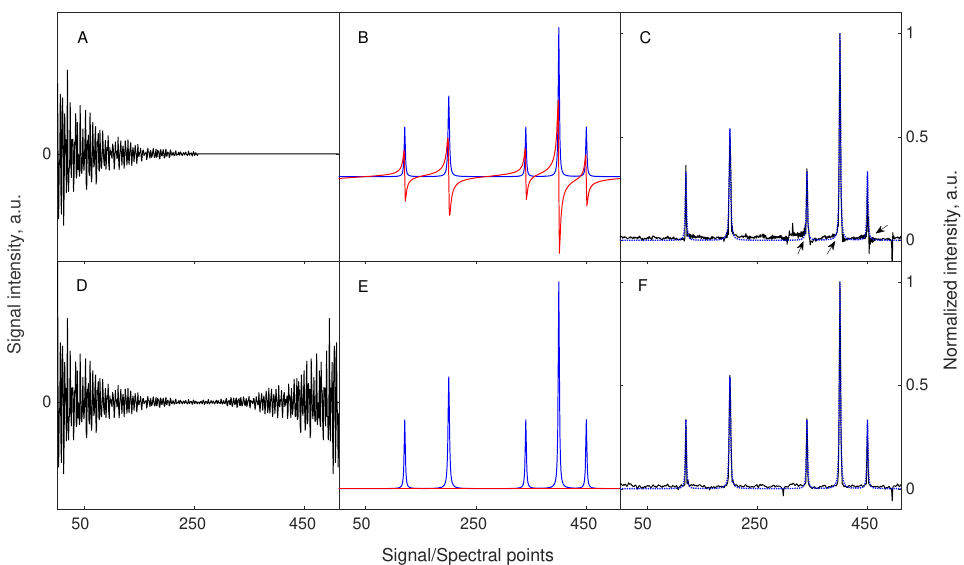
Figure 3. The concept of Virtual-Echo enhancing the compression level and improving the reconstruction quality. The upper panels ( A – C ) correspond to the signal and reconstruction without the use of VE, while the lower panels ( D – F ) correspond to the signal and reconstruction with VE pre-processing. A starting signal of 256 points length, containing 5 components of different amplitudes was zero-filled to 512 points ( A ) or processed accordingly to the VE method ( D ). The spectral representations of both signals, including the real (blue line) and imaginary (red line) parts, are shown in ( B , E ). A less sparse imaginary part of the starting signal is completely removed when VE is applied ( E ). Both signals were sub-sampled using the same sampling scheme of 48 random points. Importantly, a sampling scheme also undergoes the operation of VE in the same way as the signal. The missing points were reconstructed using 40 iterations of the CS-IRLS algorithm. The resulting spectra indicate that VE pre-processing leads to a better-quality spectrum ( F ). At this level of sampling, the spectrum reconstructed without VE pre-processing ( C ) suffers from characteristic phase distortions (see black arrows in the corresponding panel). The dotted line in panels C and F shows the real part of the fully sampled